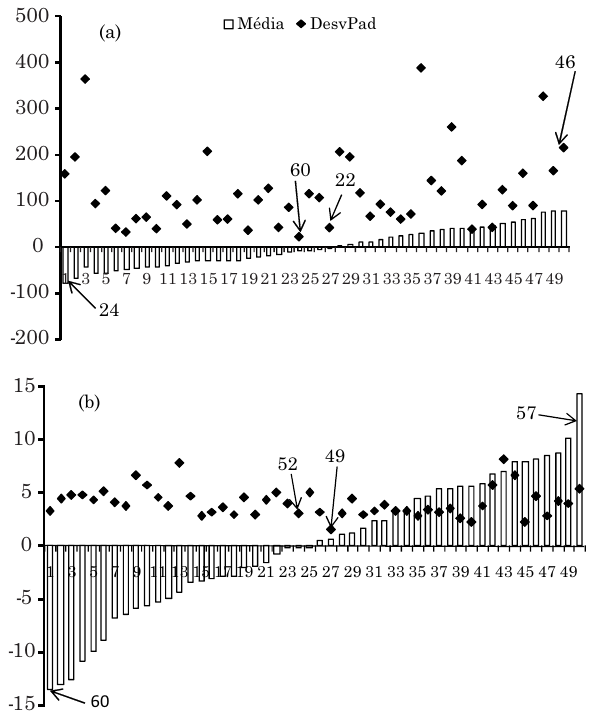
Figura 5. Diferença relativa percentual média no tempo para a drenagem interna (a) e armazenagem da água no solo (b) em cada ponto amostral a 0,8 m e respectivos desvios-padrão durante o ciclo da cultura.